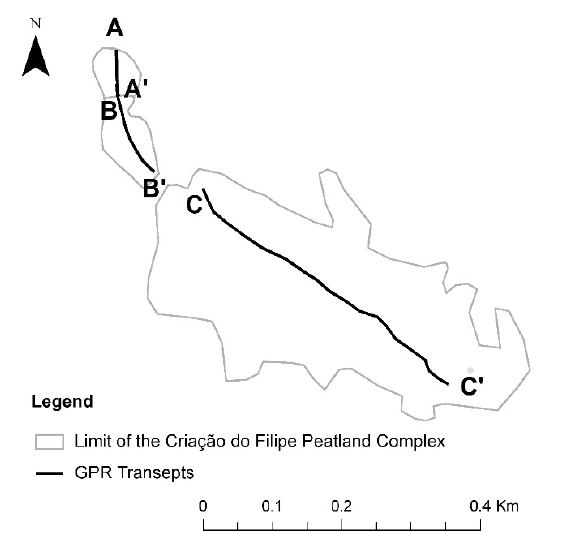
Figure 3. Location of the peat depth transepts (Figure 6) made using a MALA ® 100 MHz unshielded RTA GPR on the Criação do Filipe peatland